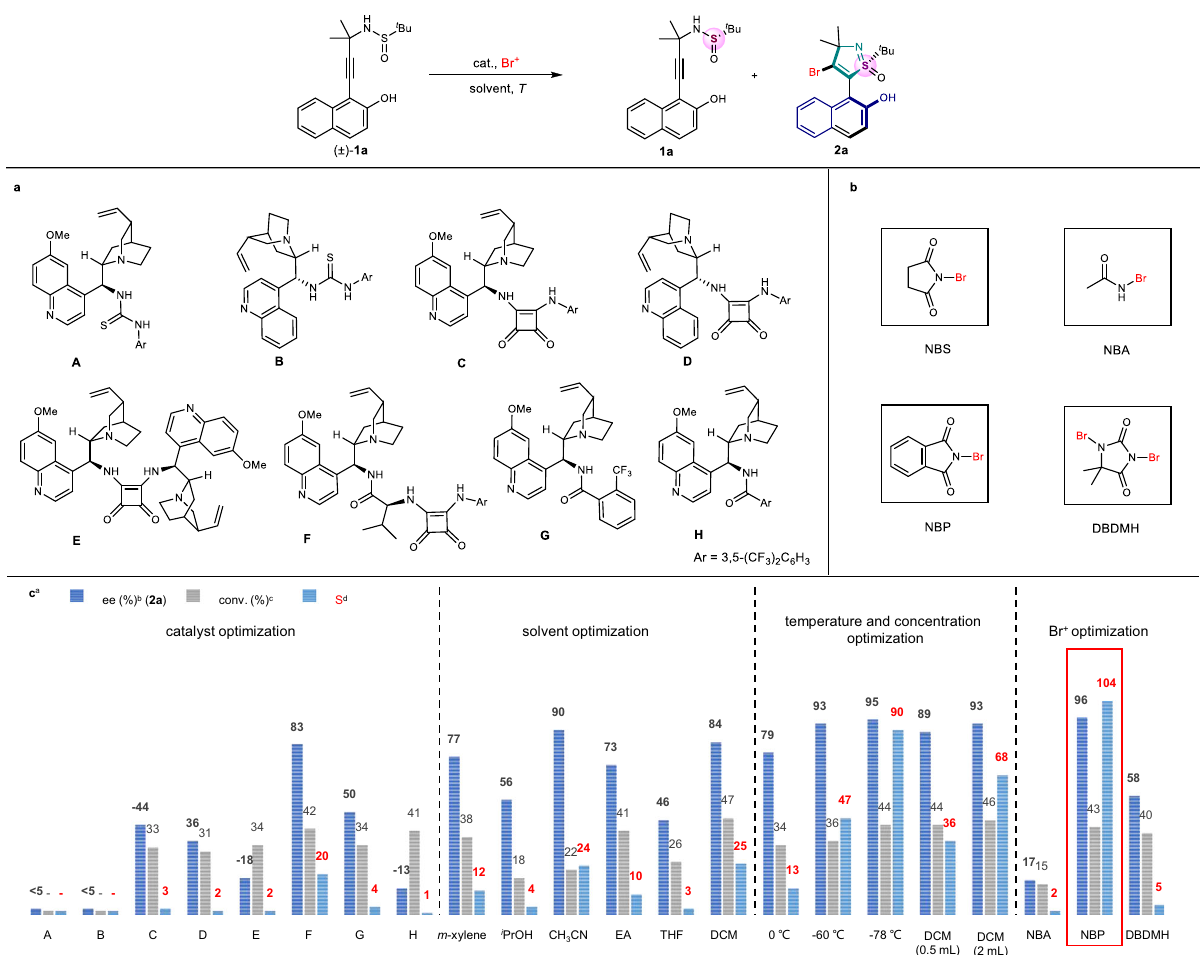
Fig. 2 Optimization of the reaction conditions. a Catalysts. b Brominating reagents: N -bromosuccinimide (NBS); N -bromoacetamide (NBA); N - bromophthalimide (NBP); 1,3-dibromo-5,5-dimethylhydantoin (DBDMH). c Reaction conditions screening. a (±) − 1a (0.05 mmol), catalysts A – H (10 mol%) in solvent at corresponding temperature for 10 min, then brominating reagents (0.0275 mmol) were added at corresponding temperature, unless otherwise speci fi ed. b Enantiomeric excess (ee) were determined by HPLC. c Conversion ratio was calculated by the methods of Fiaud: conv. = ee 1a /(ee 1a + ee 2a ). d Selectivity values were calculated by the methods of Fiaud: S = ln[(1 – conv.)(1 – ee